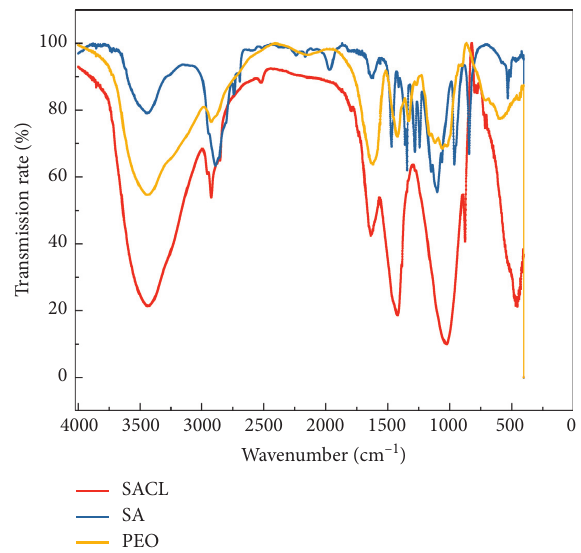
Figure 1: FTIR spectra of SACL, SA, and